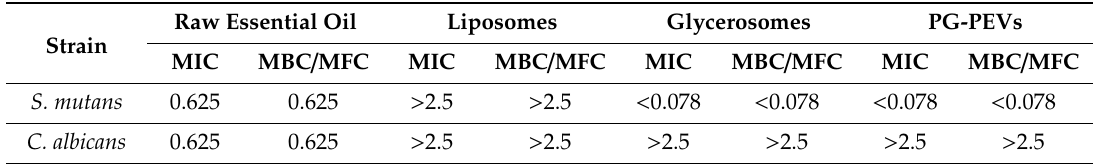
Table 7. Minimum inhibitory concentrations (MICs), minimum bactericidal concentrations (MBCs), and minimum fungicidal concentrations (MFCs) (expressed as mg / mL) of CLP extract and CLP loaded in nanovesicles against S. mutans and C. albicans determined by the broth microdilution method. Raw Essential Oil Liposomes Strain